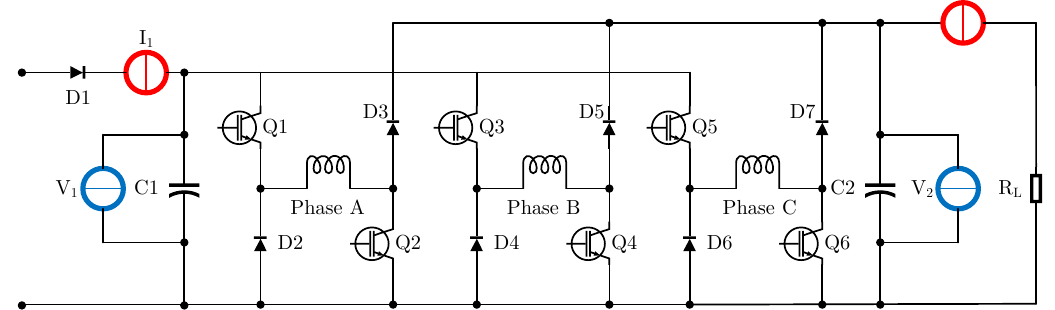
Figure 2. Schematic diagram of the AHB